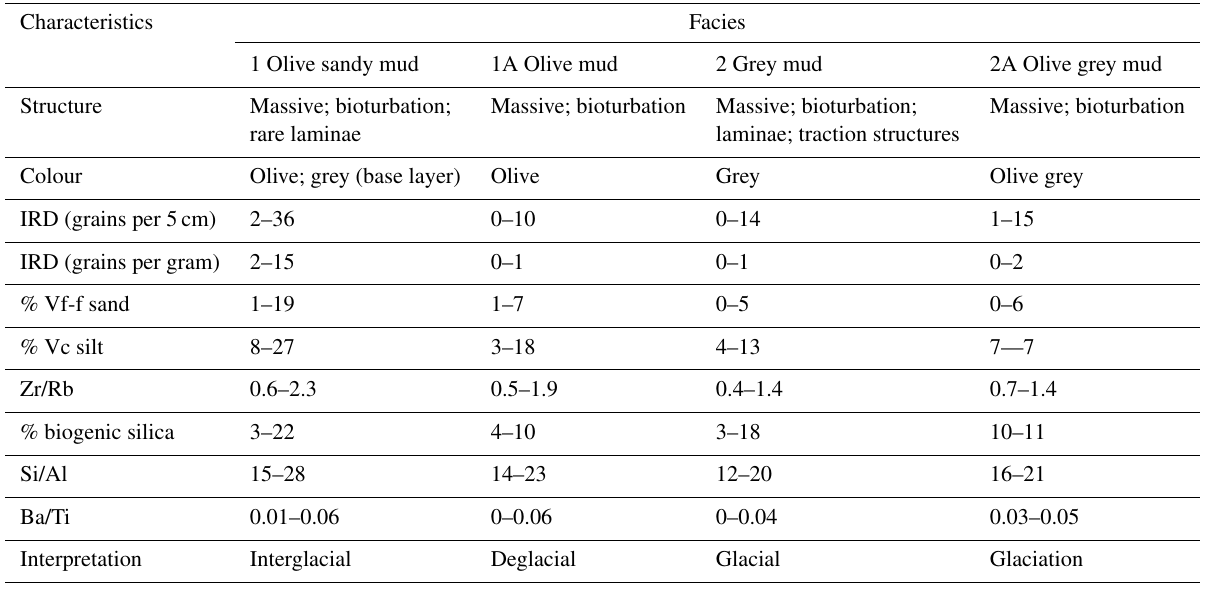
Table 1. Summary of the characteristics of the four facies present in core Tan_44.